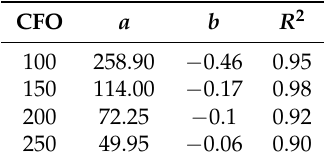
Table 4. Fitting coefficients and R 2